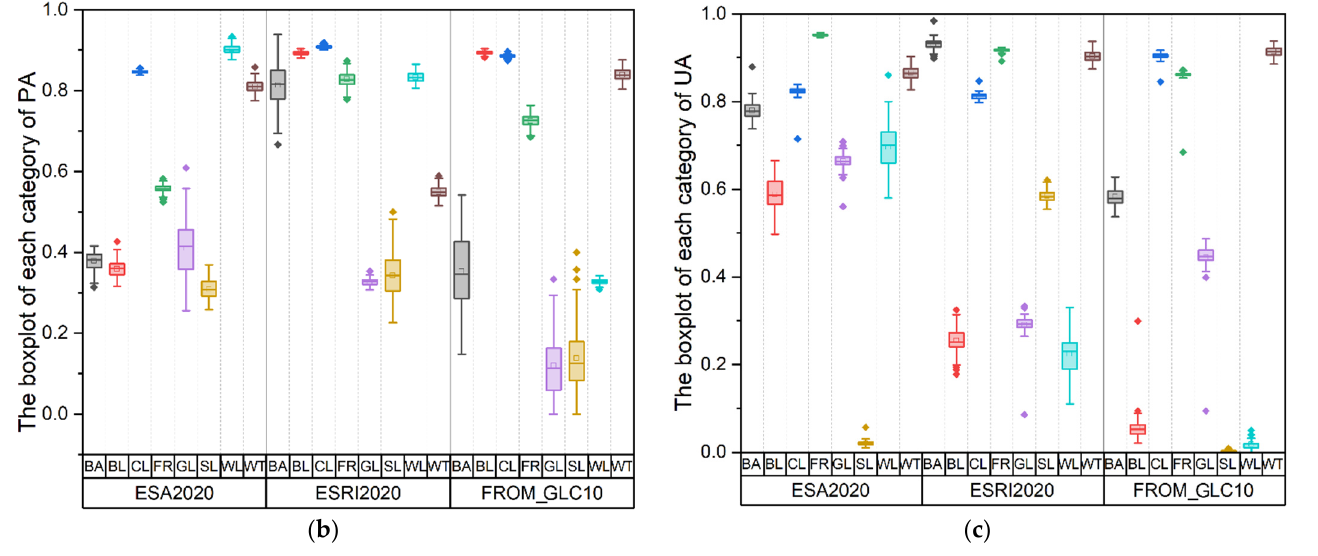
Figure 10. Boxplots of the OA, PA, and UA values. ( a ) Boxplot of the OA values of 100 samples for the three products. ( b , c ) Boxplots of the individual classes for the three products sampled 100 times, including built-up area (BA), bare land (BL), cropland (CL), forest (FR), grassland (GL), shrubland (SL), wetland (WL), and water (WT).